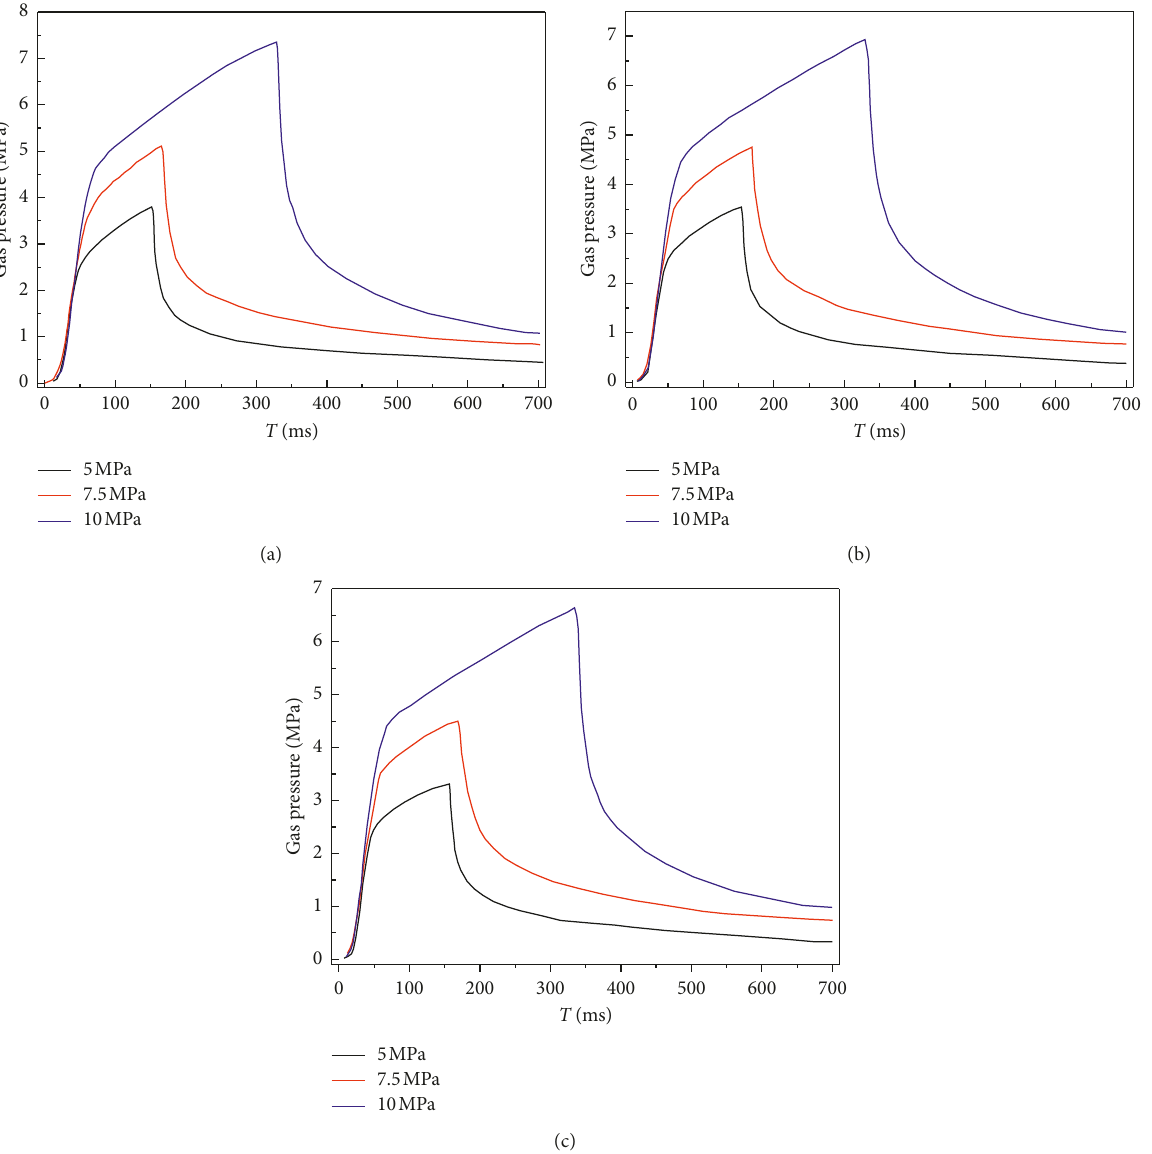
Figure 7: p - t curve of high-pressure nitrogen fracturing under different design gas pressure conditions: (a) P � 5MPa, (b) P � 7 . 5MPa, and (c) P �